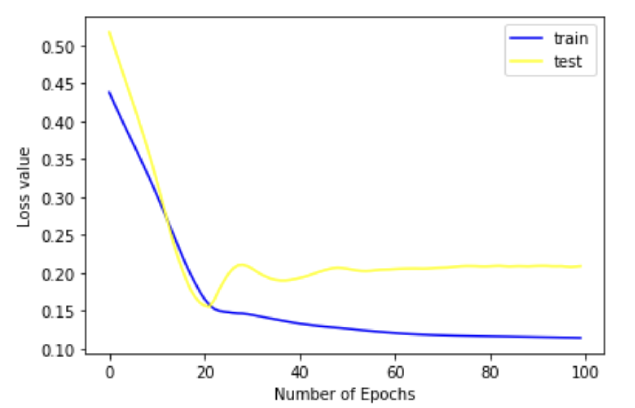
Figure 6. Loss value during